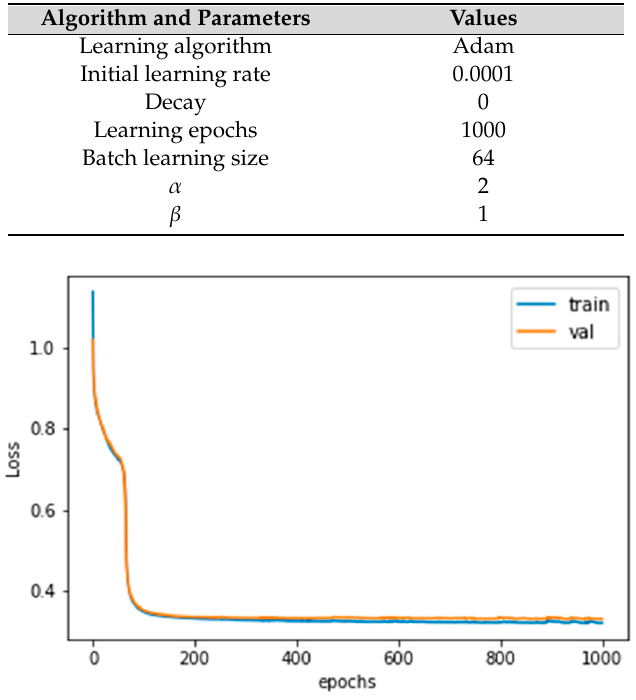
Figure 7. The training loss history.